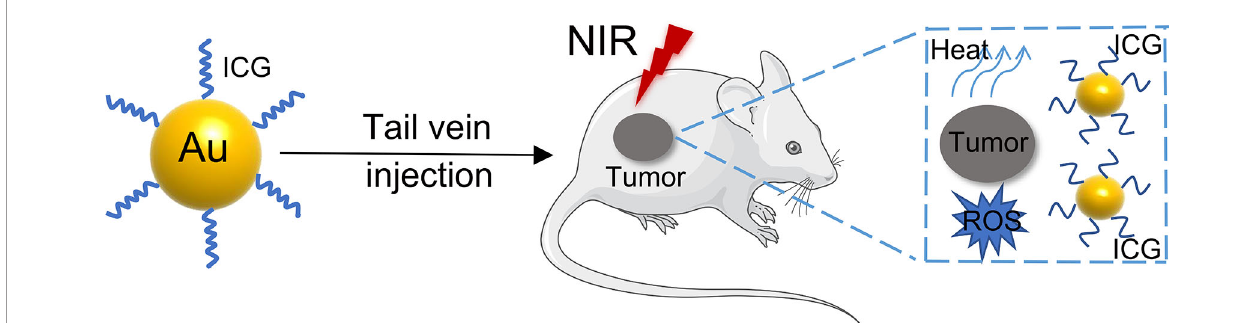
FIGURE 4 | The use of PTT and PDT combination therapy to treat tumors.